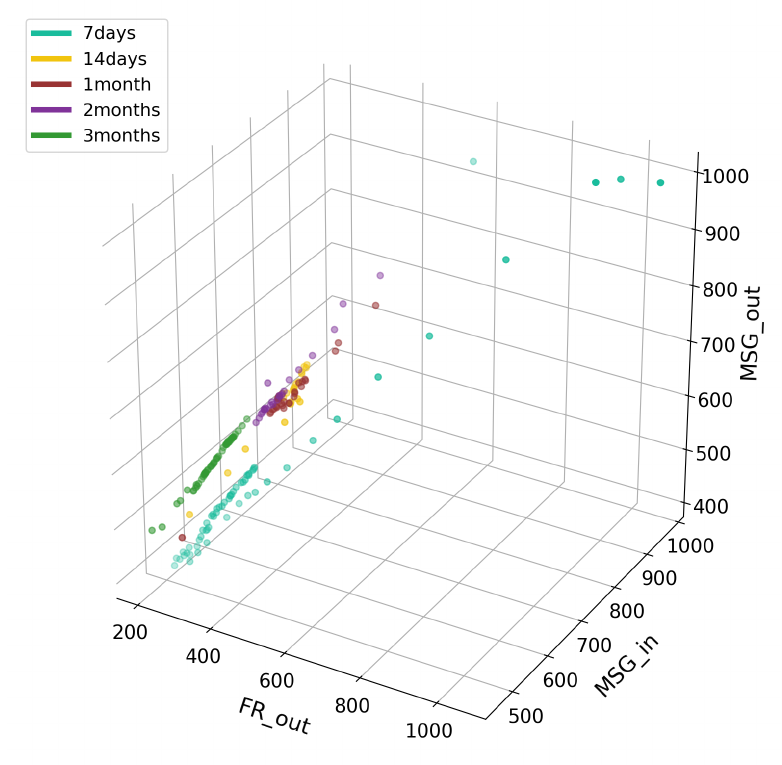
Figure 10. Dependence of objects in classes from FR_out, MSG_in and MSG_out